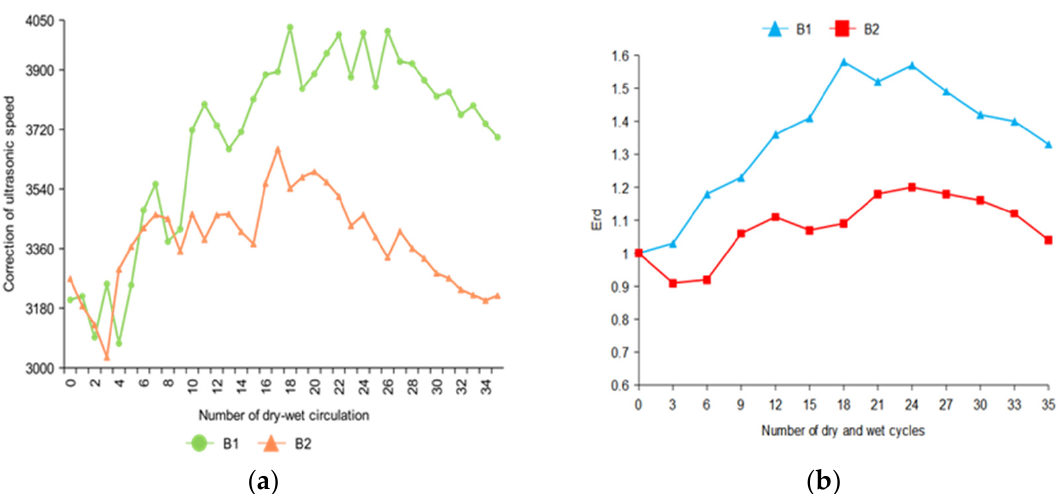
Figure 5. Changes in ultrasonic speed of concrete specimens after the correction of three-dimensional tomographic analysis. ( a ) Ultrasonic velocity loss curves of B1 and B2 concrete specimen ( b ) The ultrasonic velocity loss rate curves of B1 and B2 concrete specimens were obtained.